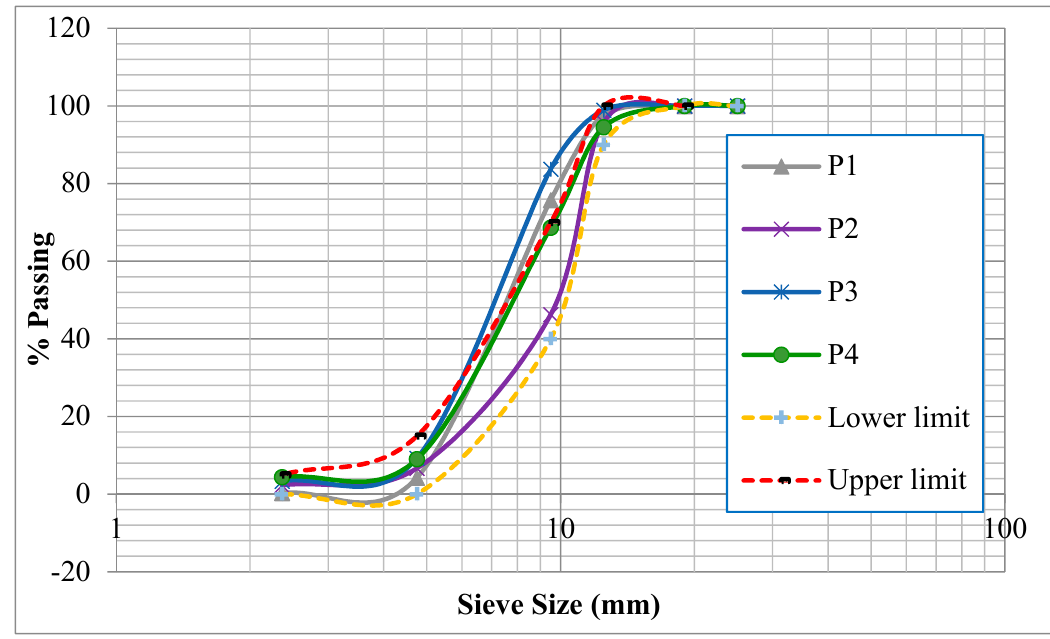
Figure 2. Sieve analysis of the four batches.